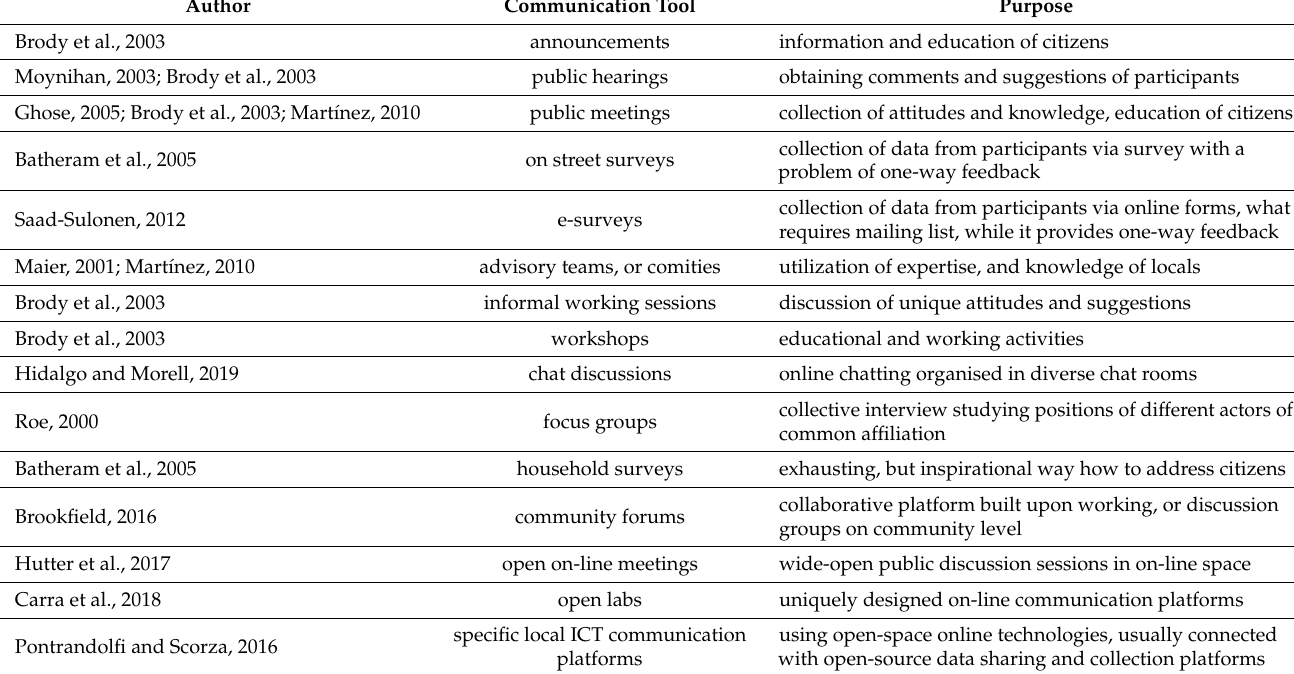
Table 3. An overview of communication tools used in participative